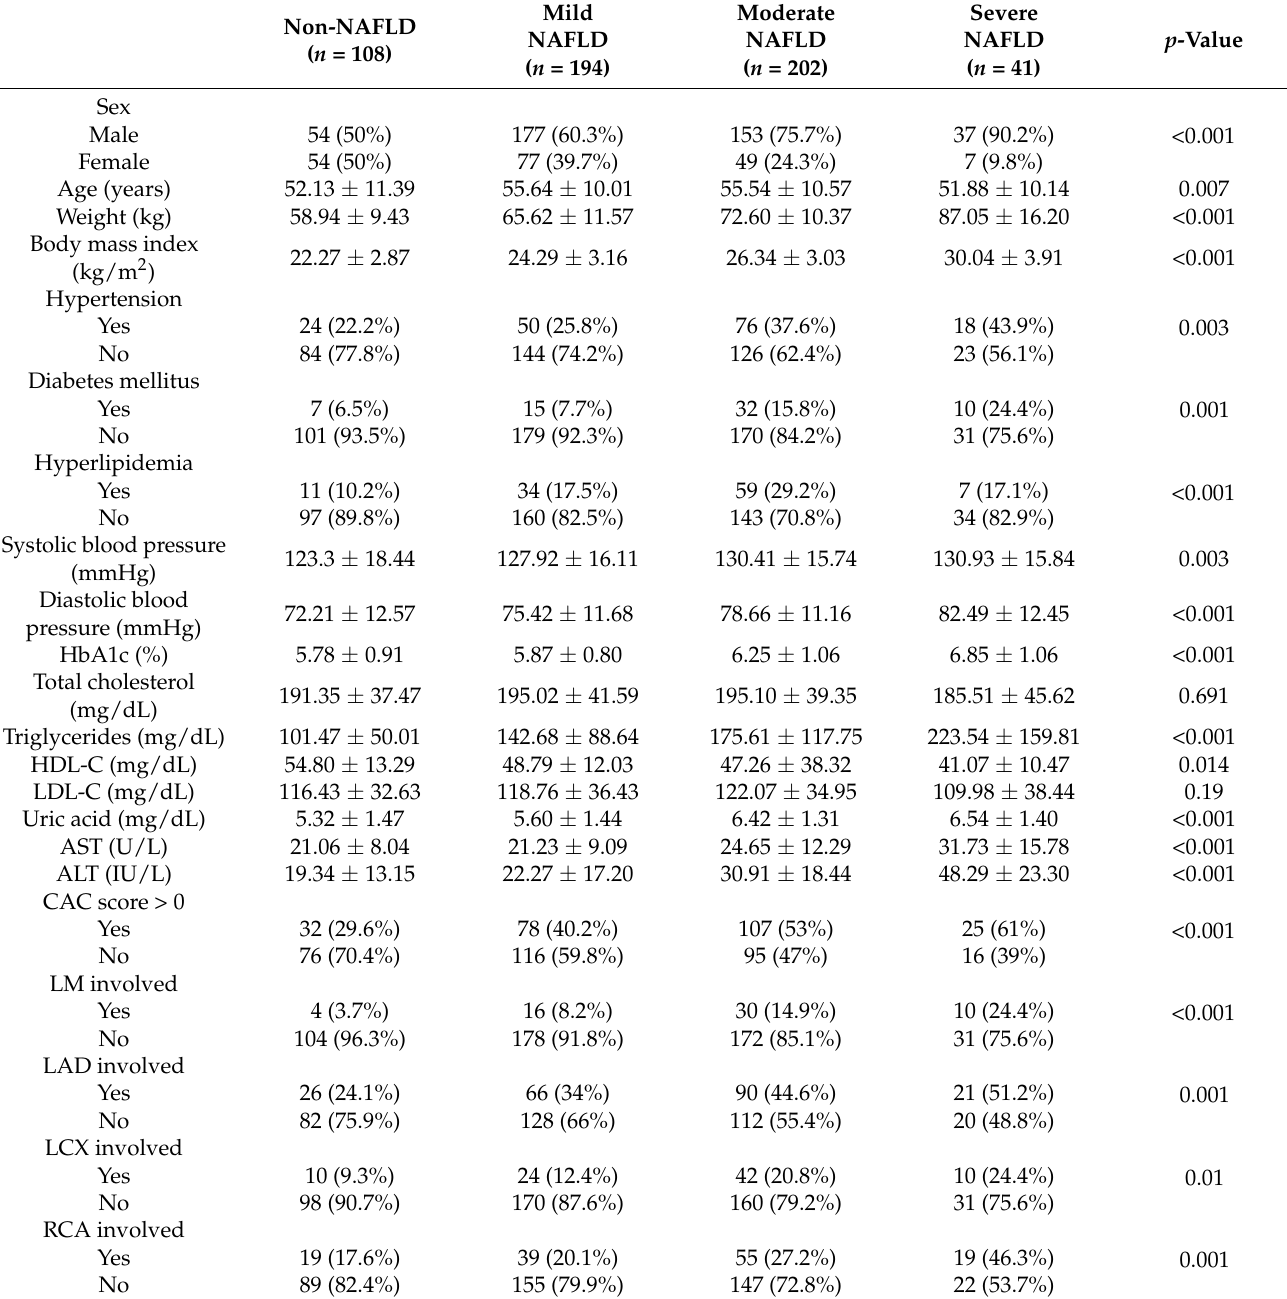
Table 2. Comparison of baseline characteristics between subjects in different